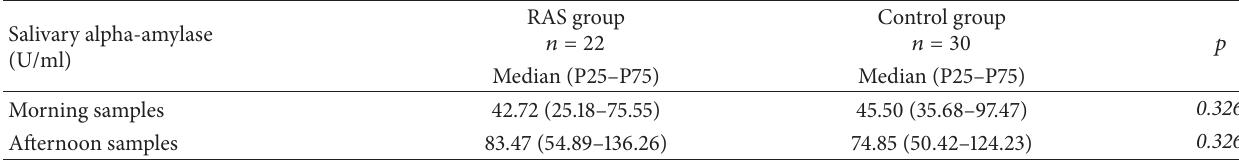
Table 1: Activity of the salivary alpha-amylase enzyme (U/ml) in the RAS and control groups. Salivary alpha-amylase